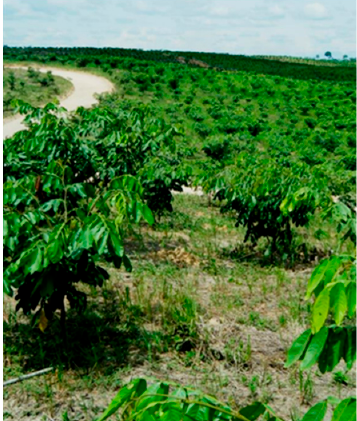
Figure 6. Planting Inga sp. and timber species.